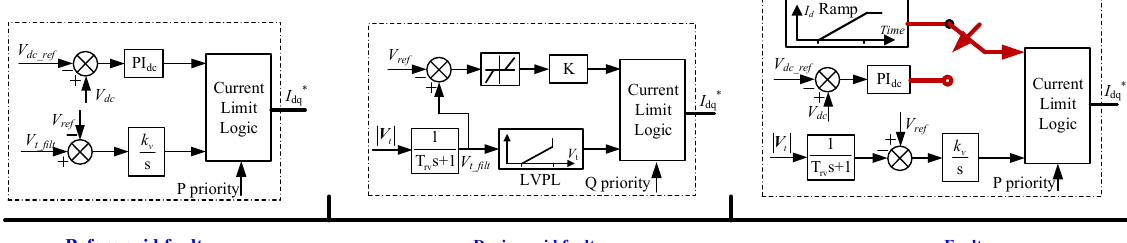
Figure 2. Transient switch control in response to grid fault.